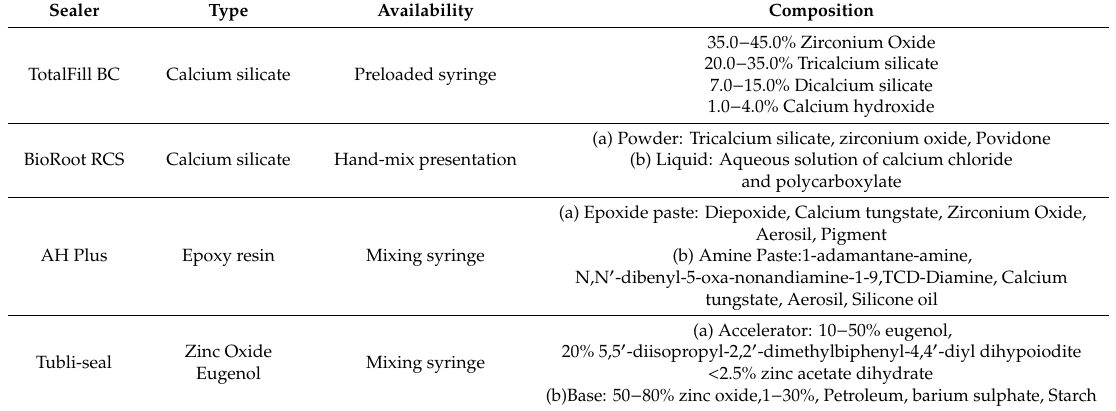
Table 1. The chemical composition of endodontic sealers tested in this